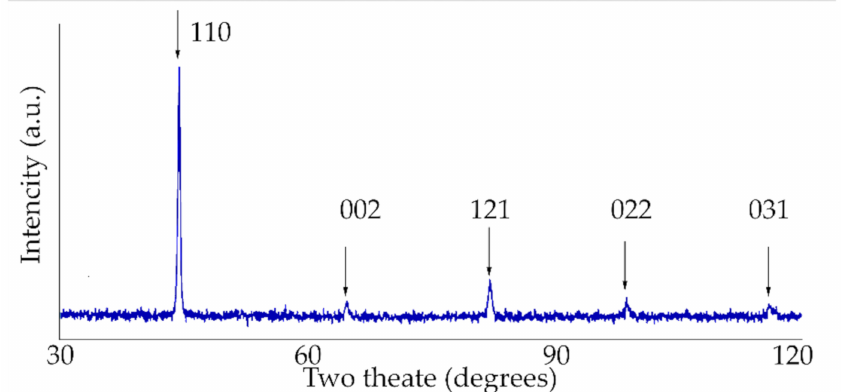
Figure 5. SEM images of microstructure: ( a ) ferrite-pearlite structure of base metal (magnification × 2000); ( b ) distance between lamella in the sorbite structure of laser-processed layer (magnification × 10,000).